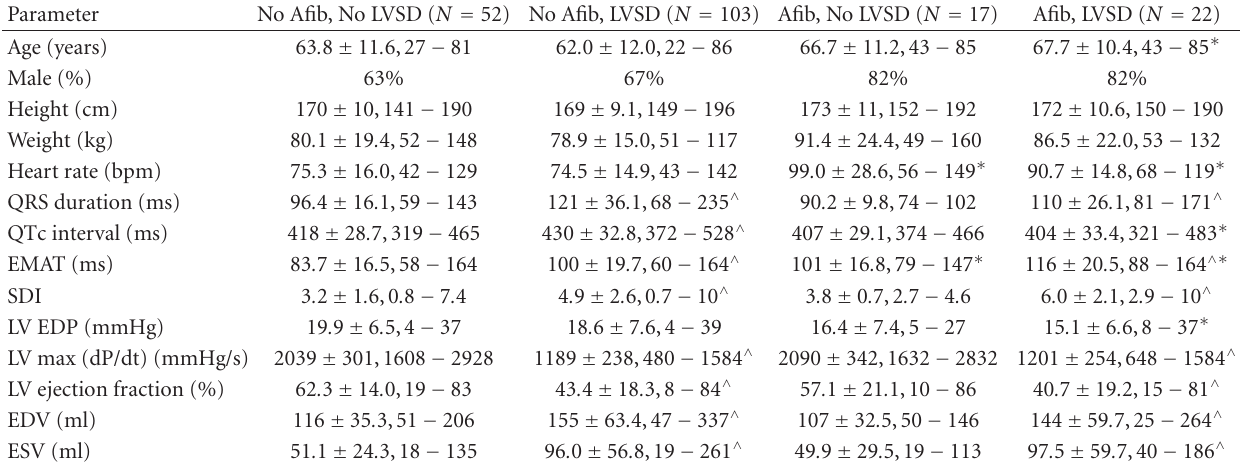
Table 1: Demographic and clinical characteristics.